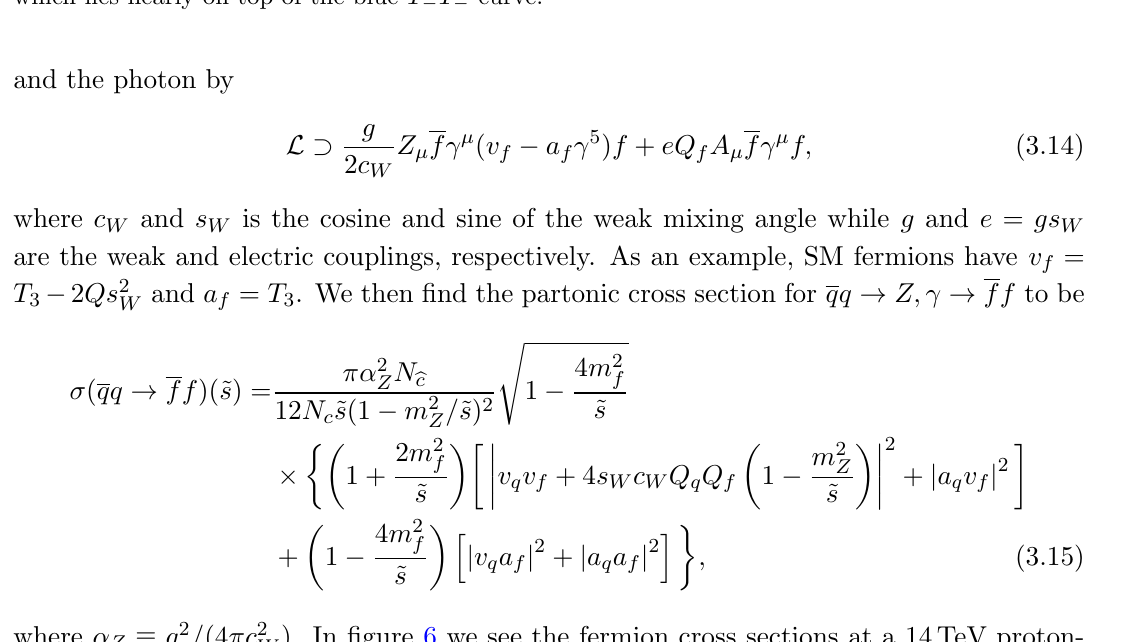
Figure 6 . Production cross sections for quirks as a function of the relevant vector-like mass at a 14 TeV proton collider for (cid:14) m = 0 : 1. The production of